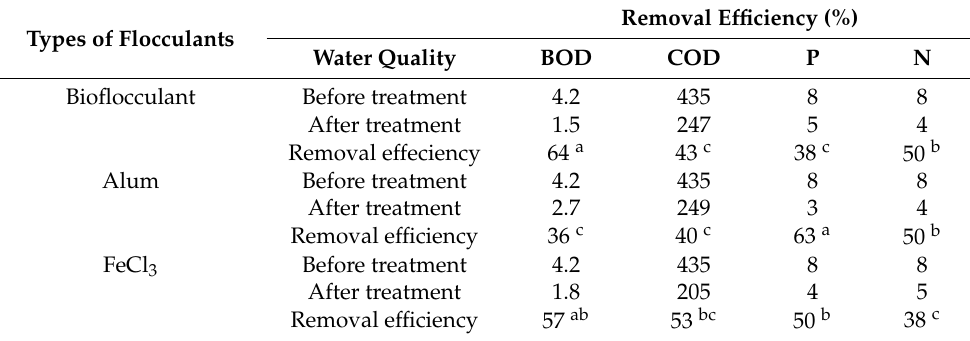
Removal Efficiency